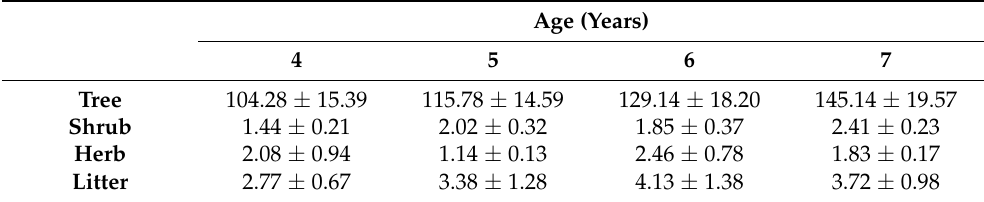
Table 5. Biomass (Mg ha − 1 ) of vegetation in M. composita plantation of different ages: (a) 4 years old; (b) 5 years old; (c) 6 years old; (d) 7 years old.